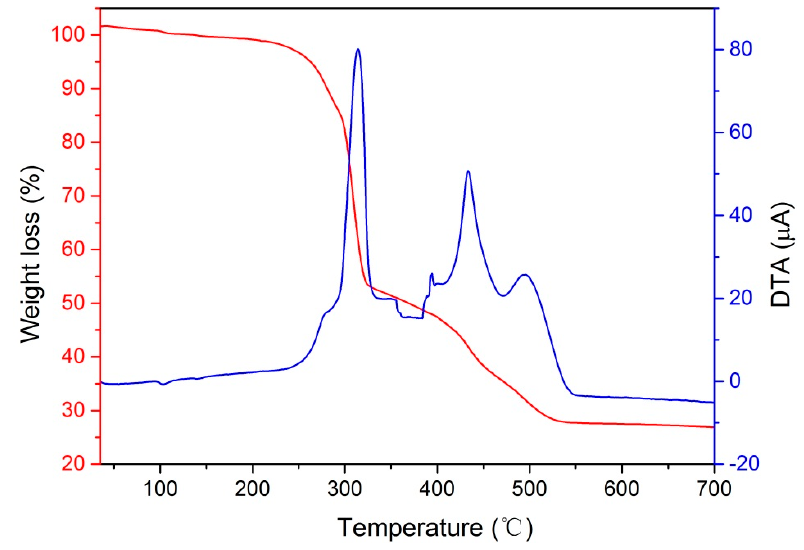
Figure 5. Thermal stability of PRC.